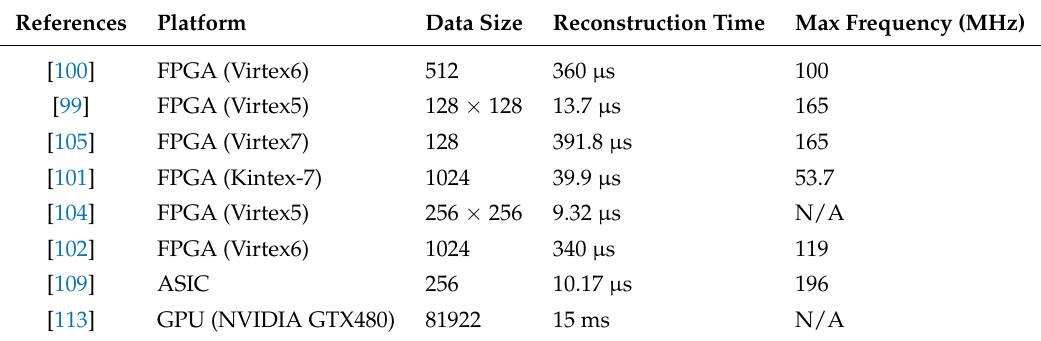
Table 3. Comparison between FPGA implementation for OMP presented in the